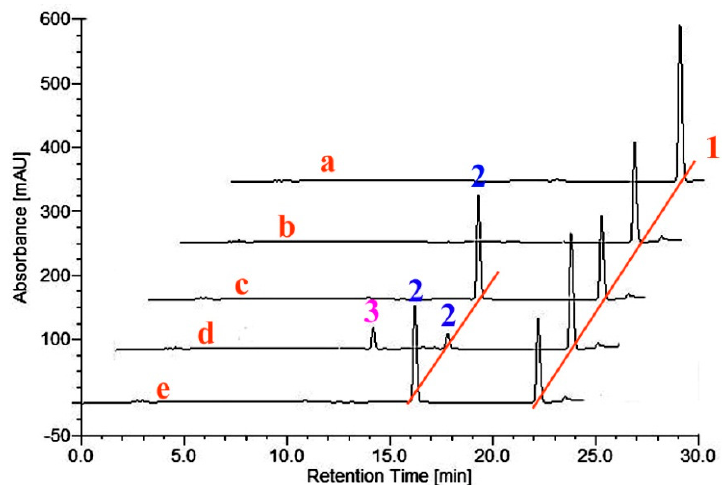
Figure 4. ( a ) HPLC chromatogram of methyltestosterone; ( b – e ) methyltestosterone incubations with empty vector, M01A82W, M01A82WS72I and M11A82W, respectively. Peak 1 is the methyl-testosterone standard; peaks 2 and 3 indicate the monohydroxy metabolites of methyltestosterone.